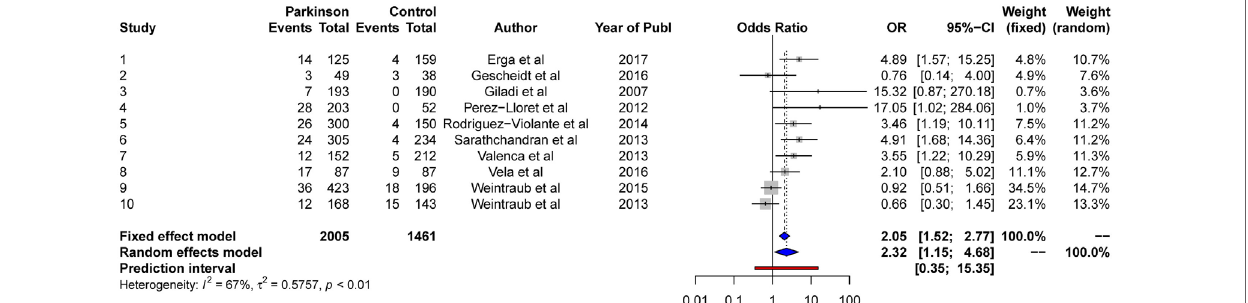
FigURe 9 | Forest plot for eating.